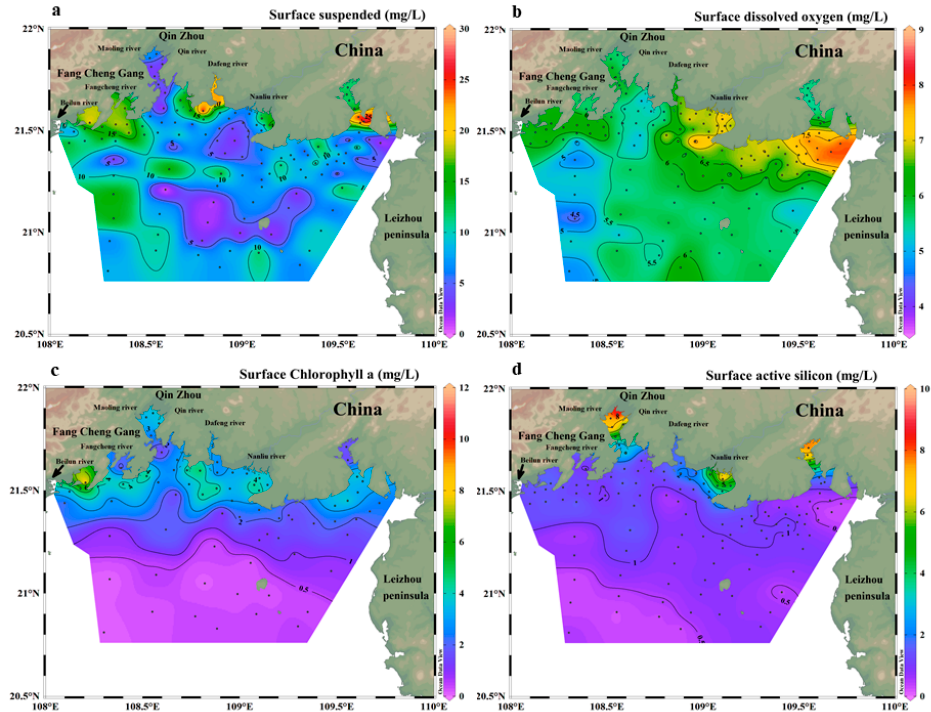
Figure 5. Surface distributions of suspended matter ( a ), dissolved oxygen ( b ), chlorophyll a ( c ), and active silicon ( d ) during our investigation period in May 2021.